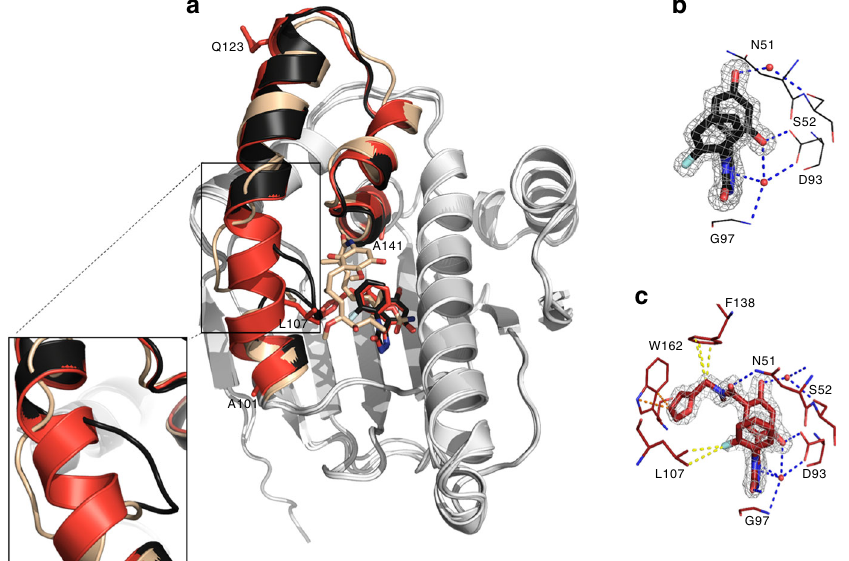
Fig. 2 Comparison of different conformations of N-HSP90. a Overlay of three N-HSP90 crystal structures in complex with compounds 1 (black), 20 (red) and geldanamycin (wheat, PDB 1YET), representing loop-in, helical and loop-out conformations, respectively. The protein structures are shown in gray except α -helix3 (residues 101 – 123) and the lid segment (residues 107 – 141). A detailed view of the different conformations of α -helix3 is given in the inset. b Protein-ligand interactions representative of the loop-in conformation (compound 1 ). c Protein-ligand interactions representative of the helical conformation (compound 20 ). Dashed lines indicate interactions (blue: hydrogen bonds, yellow: aromatic, brown: hydrophobic). 2F o -F c electron density maps, contoured at 1.5 σ , are shown in gray around each